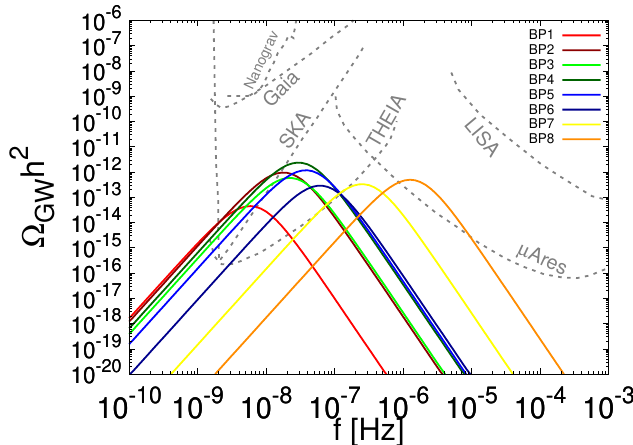
Figure 6 . The gravitational wave power spectra for the benchmark points in table 1 labeled in order of increasing peak frequency.